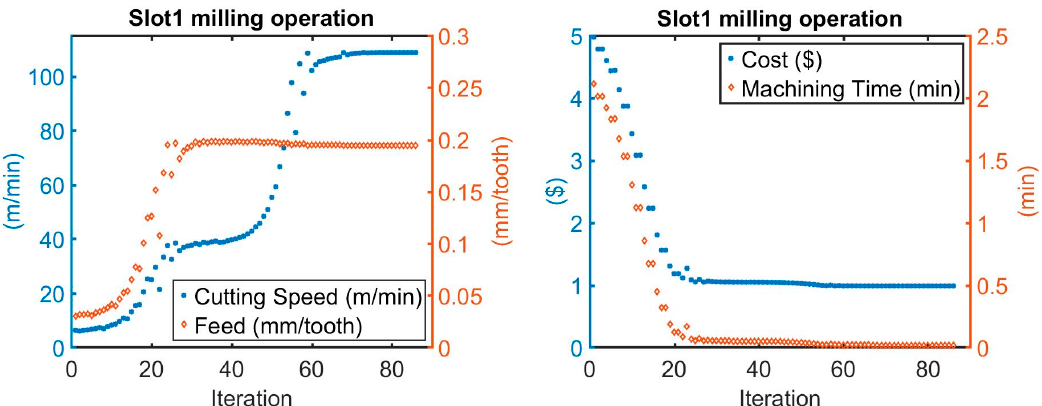
Figure 9. Machining parameters ( left ) and results ( right ) for slot1 operation of the case study. Table 8. Initial and optimum parameters of slot1 milling.